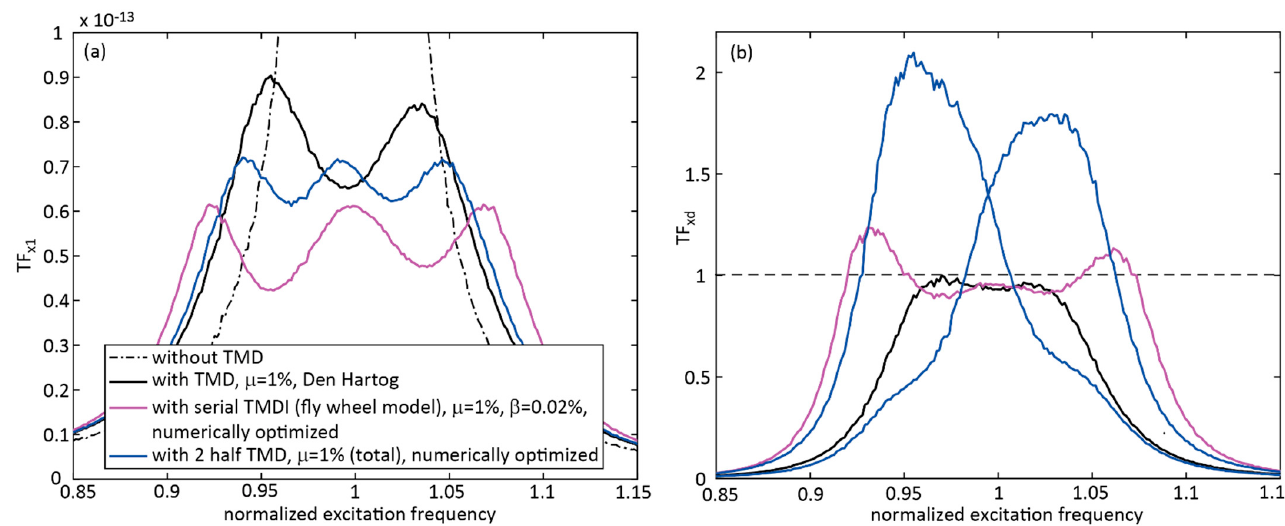
Figure 12. Performances of TMDI with serial arrangement of stiffness, inerter and damper ( 𝜇 = 1%, 𝛽 = 0.02%, numerically optimized parameters), TMD ( 𝜇 = 1%, Den Hartog parameters) and two half TMDs ( 𝜇 = 1%, numerically optimized parameters) for random excitation: (a) primary structure normalized displacement response and (b) normalized damper relative motion response